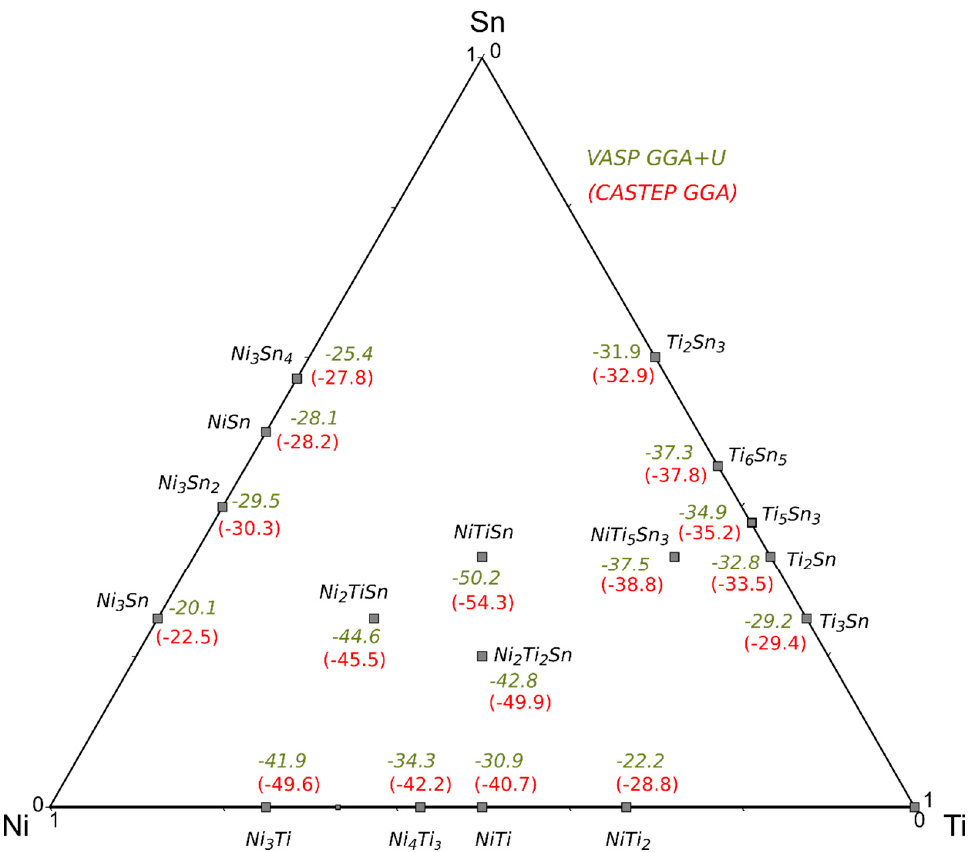
Figure 7. Calculated formation enthalpies (in kJ/mol of atom) for binary and ternary compounds in the Ni-Ti-Sn ternary diagram.